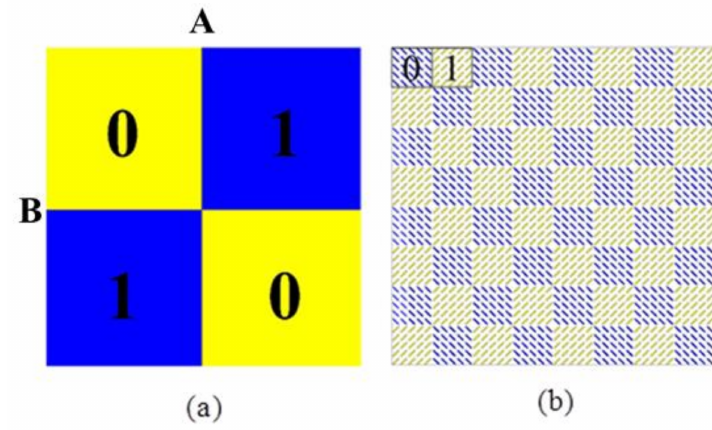
Figure 4. ( a ) 2 × 2 structure arrangement of the 01/10 coding MS; ( b ) illustration of the 01/10 coding MS; the “0” and “1” indicate the super-cells, and are distinguished by blue and yellow colors; each super-cell consists of 5 × 5 unit-cells of “0” and “1”, shown in Figure